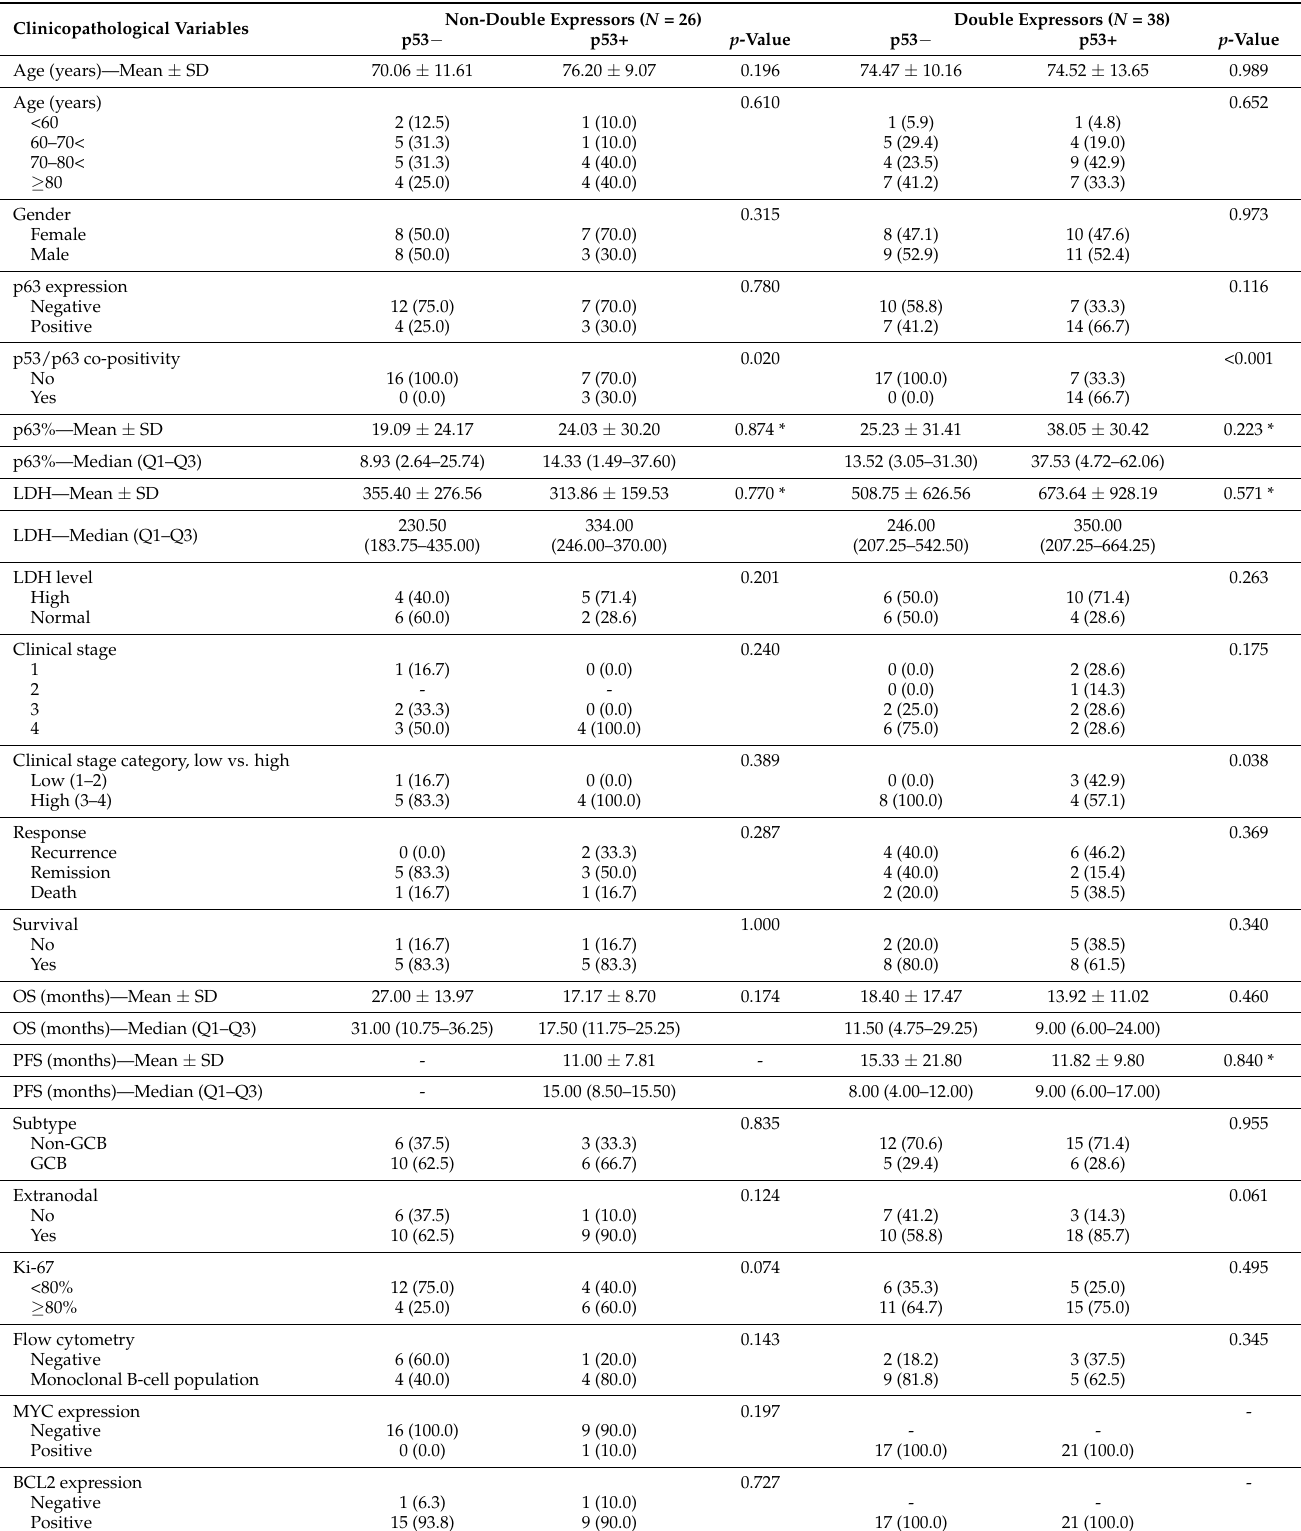
Table 4. Correlation between p53 positivity and clinicopathological characteristics of patients strati- fied into non-double expressors and double expressors ( N =